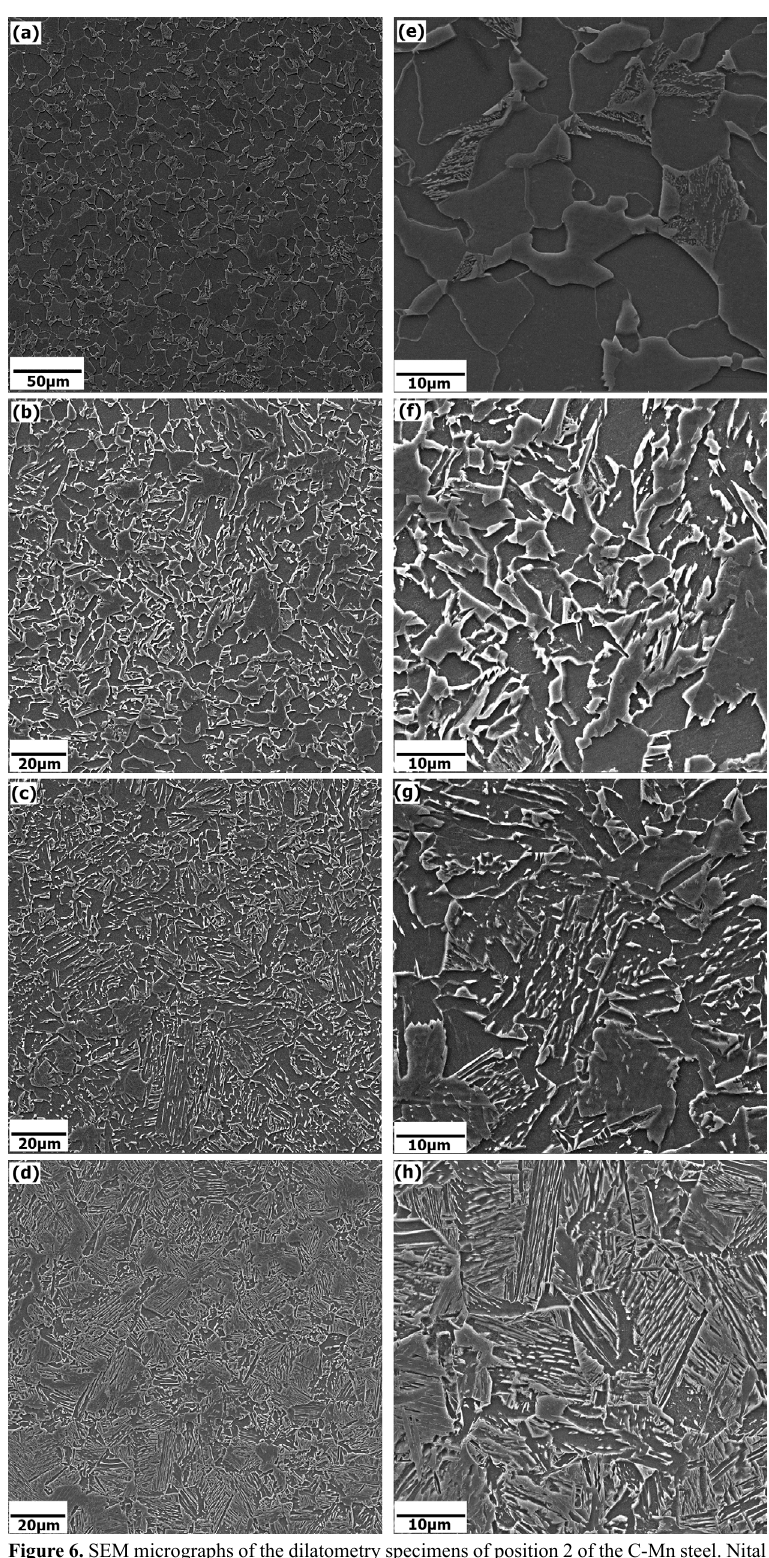
Figure 6. SEM micrographs of the dilatometry specimens of position 2 of the C-Mn steel. Nital 2%. (a) and (e) 2°C/s (PF+P+P’); (b) and (f) 7°C/s (QF+GF +BF); (c) and (g) 20°C/s (GF+BF); (d) and (h) 100°C/s